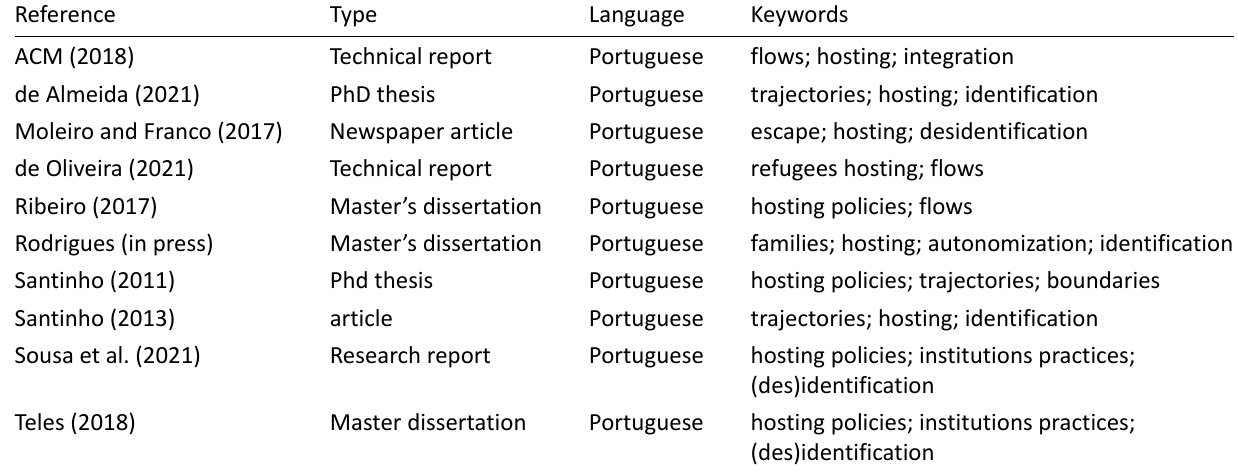
Table 1. List of references